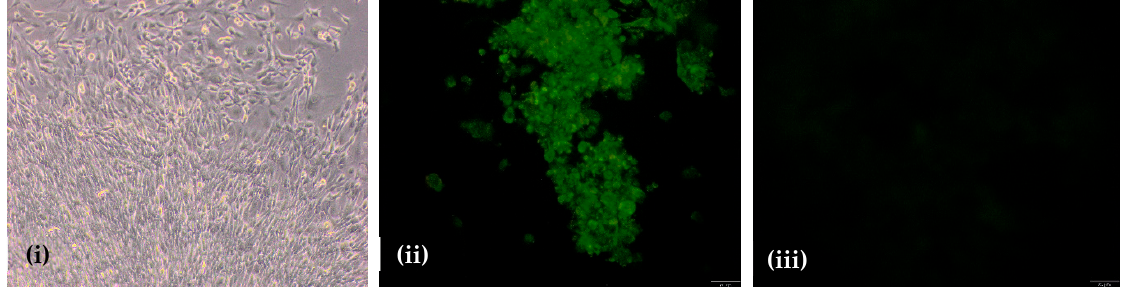
Figure 4. The effect of root extracts concentration on cell viability on NIH 3T3 cells lines.